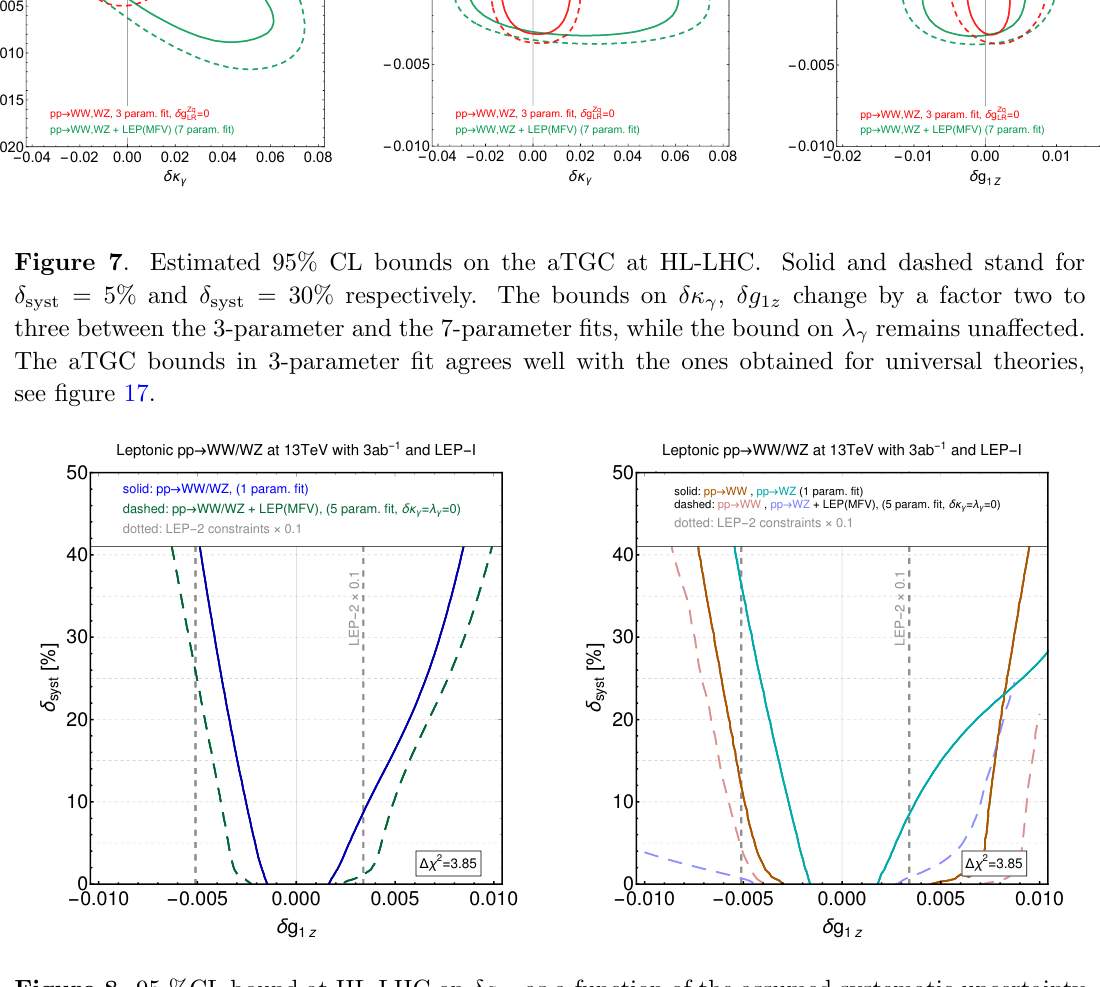
Figure 8 . 95 %CL bound at HL-LHC on (cid:14)g 1 z as a function of the assumed systematic uncertainty for the case where the light quark vertices are neglected and for the case where we take them into account and combine the (cid:12)t with LEP-1 data. For comparison, in light gray we show the LEP-2 constraints, rescaled by a factor 0.1. Left: (cid:1) (cid:31) 2 combining the projections for WW and WZ . Right: showing the projected (cid:1) (cid:31) 2 for the WW and WZ channels